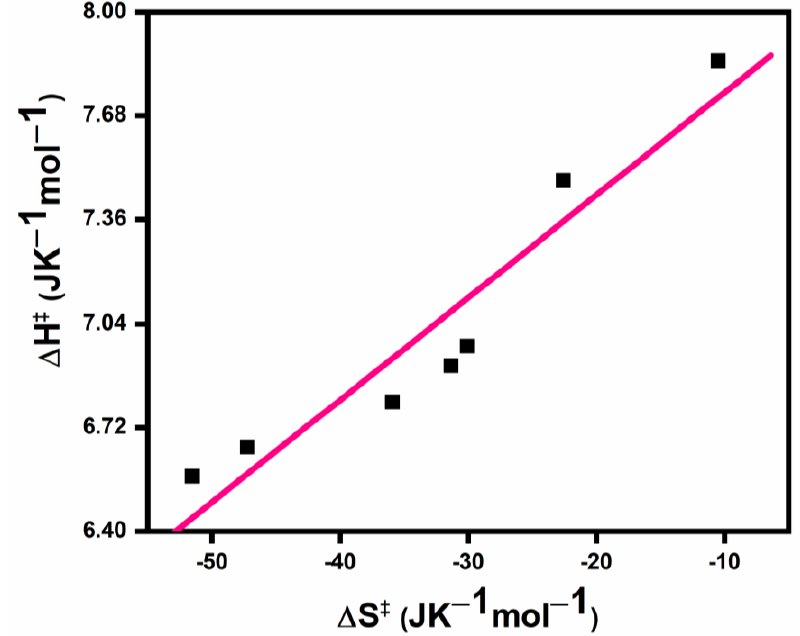
Figure 6. Isokinetic plot of the activation parameters for the reduction of cis- [Co(ip) 2 (C 12 H 25 NH 2 ) 2 ](ClO 4 ) 3 by ion(II) in [BMIM]Br medium. [Complex] = 4 × 10 − 4 mol dm − 3 ; [Fe(CN) 6 ] 4− = 0.01 mol dm − 3 ; [μ] = 1.0 mol dm − 3 . (Entropy and Enthalpy of activation is symbolized ΔS ‡ and ΔH ‡ ). Table 4. Activation parameters for the reduction of cis-[Co(ip) 2 (C 12 H 25 NH 2 ) 2 ](ClO 4 ) 3 , μ = 1.0 moldm − 3 in [BMIM]Br medium.